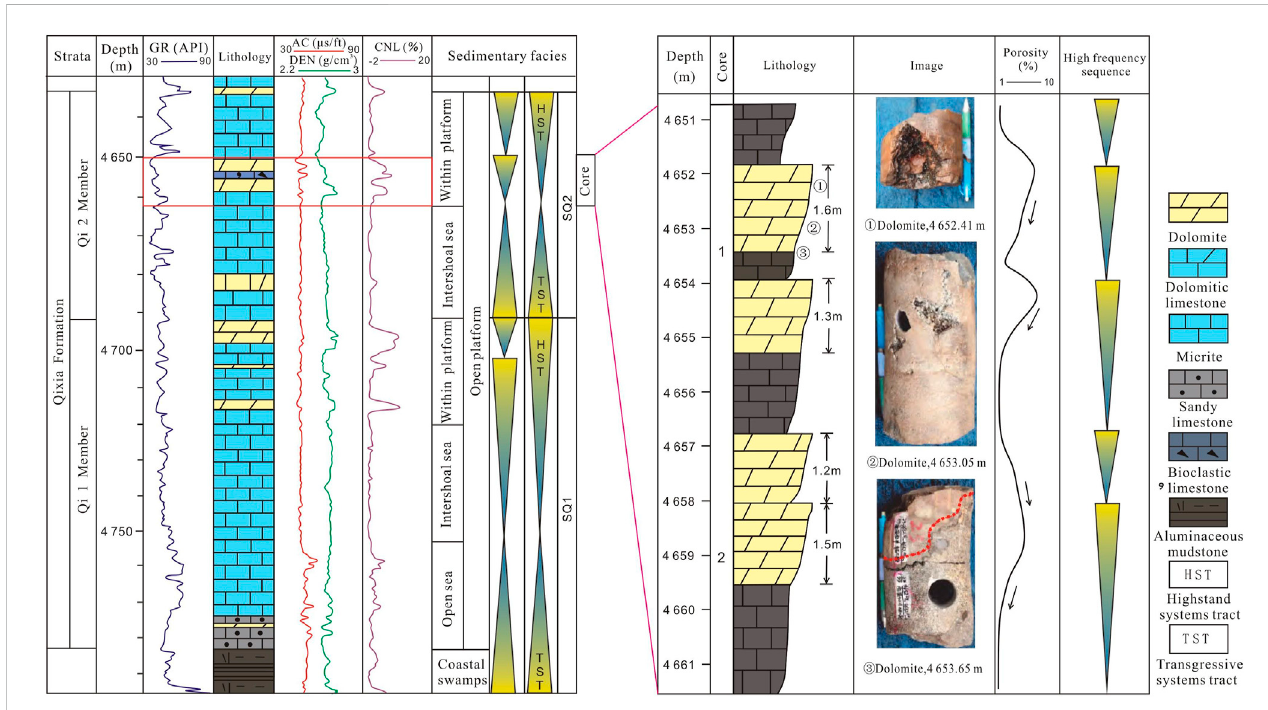
FIGURE 9 Comprehensive lithologic histogram of ixia Formation in Well Moxi 42 (modi fi ed after Duan et al., 2021).